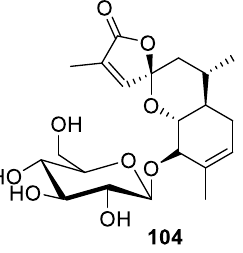
Figure 45. Secochiliolide acid.